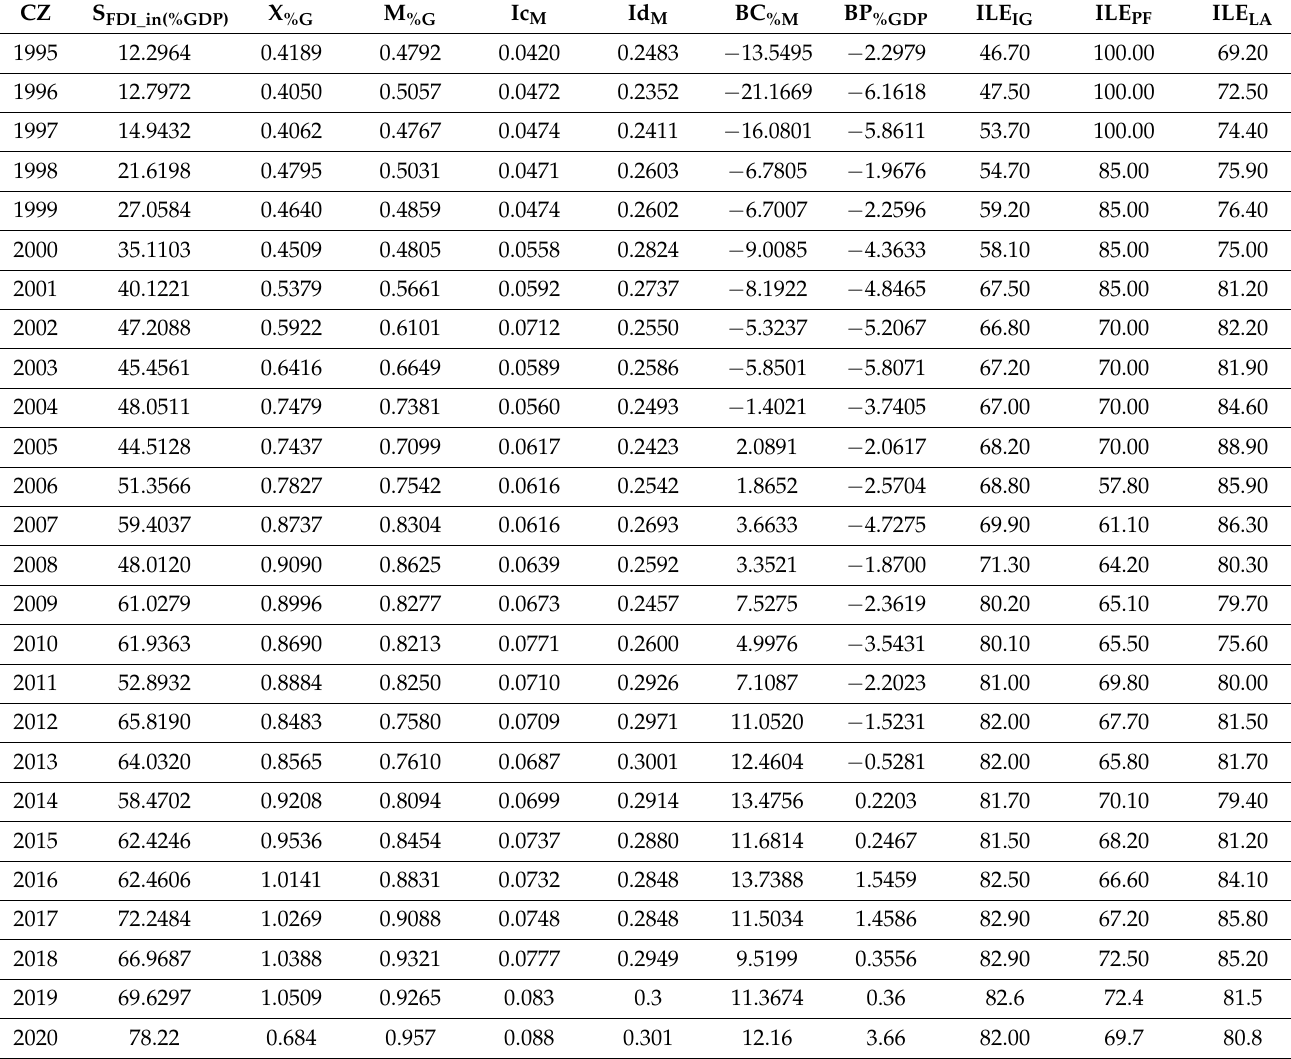
Table A1. Values of economic indicators for the Czech